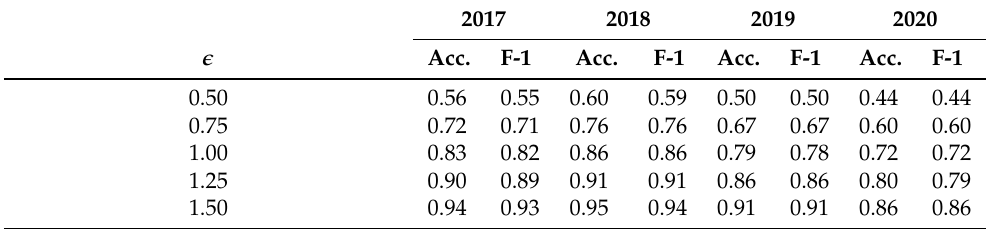
Table 4. Classification accuracy and F-1 score based on varying error tolerance, (cid:101) in tons/hectare, based on the LGBM model trained with Ψ = G-50 and ¯ x = All features. Note that the performance increases significantly between (cid:101) ∈ [ 0.5,1.0 ]